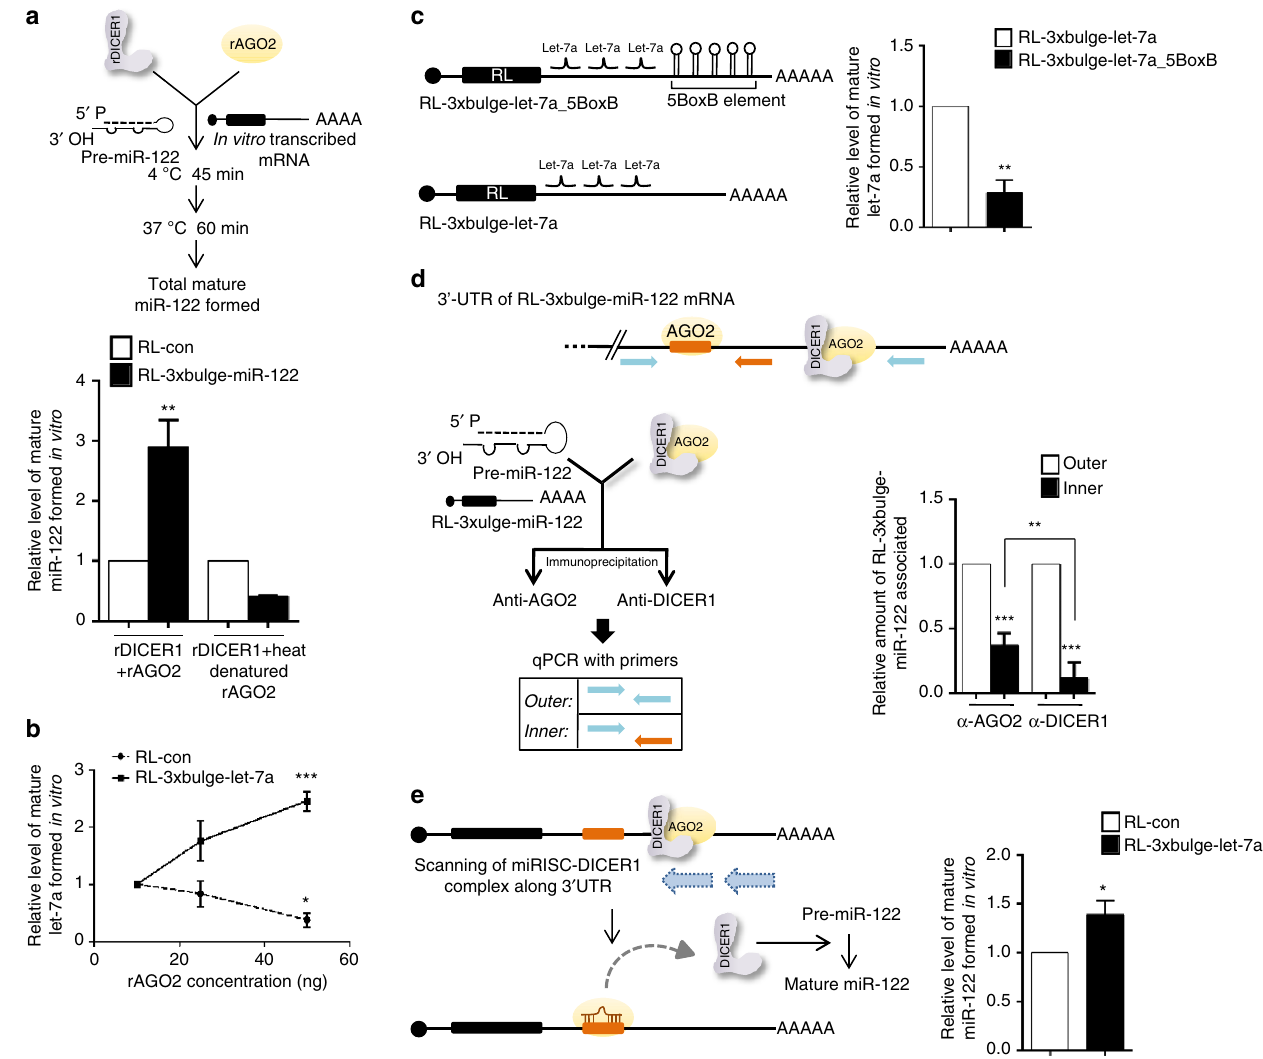
Figure 6 | Increased processivity of AGO2-associated DICER1 in the presence of target mRNA. ( a ) In vitro pre-miRNA processing assay with rAGO2 and rDICER1 reconfirmed target mRNA-driven increase in AGO2-associated DICER1 activity. In vitro pre-miRNA processing assay with rDICER1 and rAGO2 (native or heat-denatured) to quantify miR-122 biogenesis in the presence of target mRNA. Heat denaturation of rAGO2 was carried out at 95 (cid:2) C for 5min followed by rapid chilling. ( b ) In vitro pre-miRNA processing assay of pre-let-7a with rDICER1 and increasing concentrations of rAGO2 (10, 25 and 50ng) in the presence of RL-con or RL-3 (cid:2) bulge-let-7a (25ngml (cid:3) 1 ). Mature let-7a levels were measured and plotted. ( c ) Schematic representation of RL-3 (cid:2) bulge-let-7a_5BoxB mRNA used in the in vitro assays. In vitro pre-miRNA processing assay of pre-let-7a with rDICER1 and 50ng rAGO2 in the presence of RL-3 (cid:2) bulge-let-7a or RL-3 (cid:2) bulge-let-7a_5BoxB mRNA (both at 25ng m l (cid:3) 1 ). Mature let-7a levels after the reaction were measured and plotted. ( d ) In vitro assay to measure the association of AGO2 and DICER1 along the 3 0 -UTR of target mRNAs. FH-AGO2 immunoprecipitated from HEK293 cells transiently expressing NHA-DICER1 was subjected to in vitro pre-miRNA processing assay with pre-miR-122 and RL-3 (cid:2) bulge-miR-122 as described earlier, followed by immunoprecipitation of AGO2 and DICER1 with antibodies specific to endogenous proteins. Quantitative reverse transcriptase PCR (qRT-PCR) was done with indicated primers. ( e ) In vitro assay to measure processivity of DICER1. Immunopurified AGO2 (let-7a miRISC) incubated with 25ngml (cid:3) 1 RL-con or RL-3 (cid:2) bulge-let-7a in the presence of pre-miR-122 (10nM) at 37 (cid:2) C for 30min followed by RNA isolation and quantification of mature miR-122 formed by qRT-PCR. Paired two-tailed Student’s t -tests were used for all comparisons. * P o 0.05, ** P o 0.01 and *** P o 0.001. In a – e , values are means from at least three biological replicates. Error bars represent